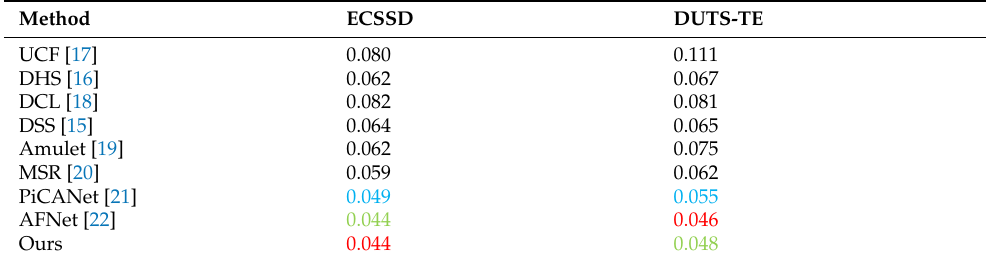
Table 1. Quantitative comparisons with different methods on 2 datasets with MAE. The best three results are shown in red, green and blue.